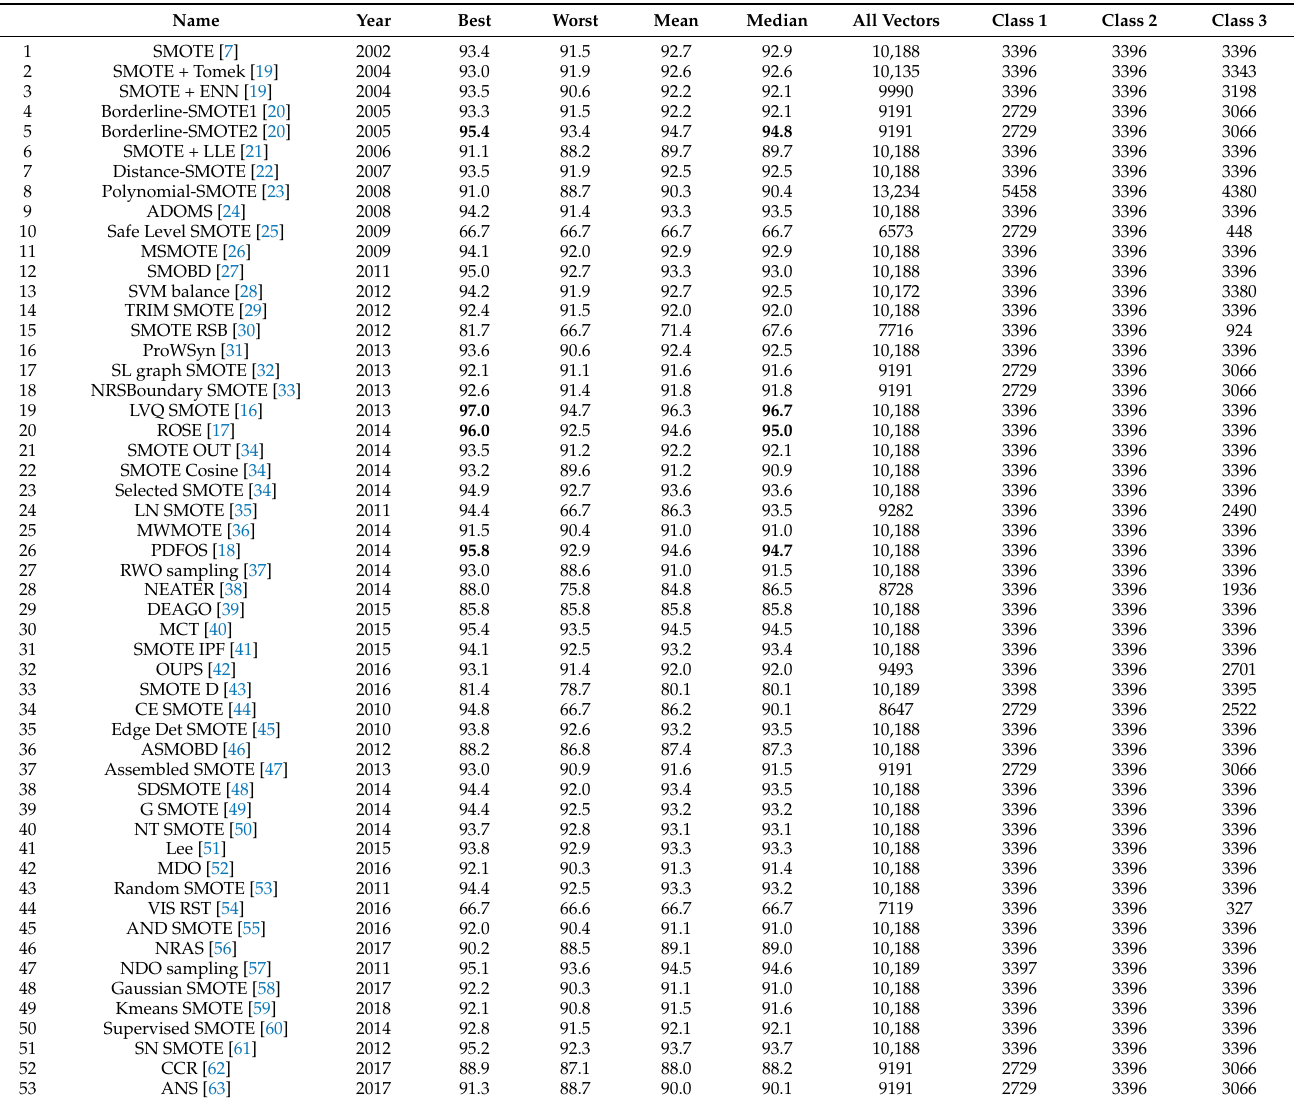
Table 3. Results of classification with balanced